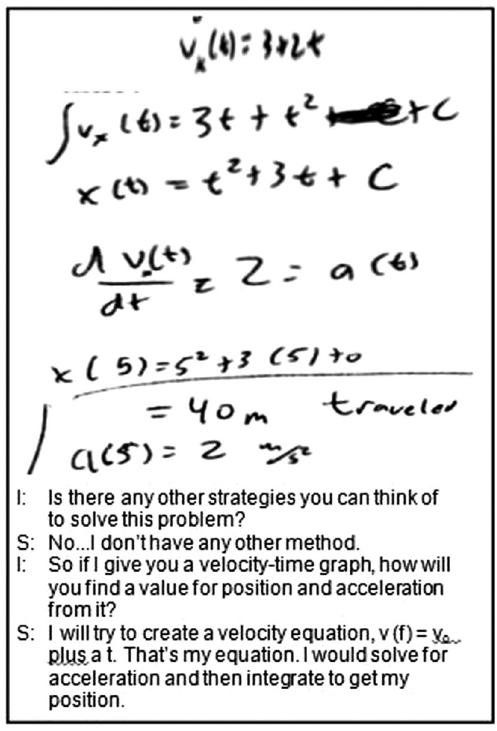
FIG. 5. Solve value from symbolic representation (question 3).